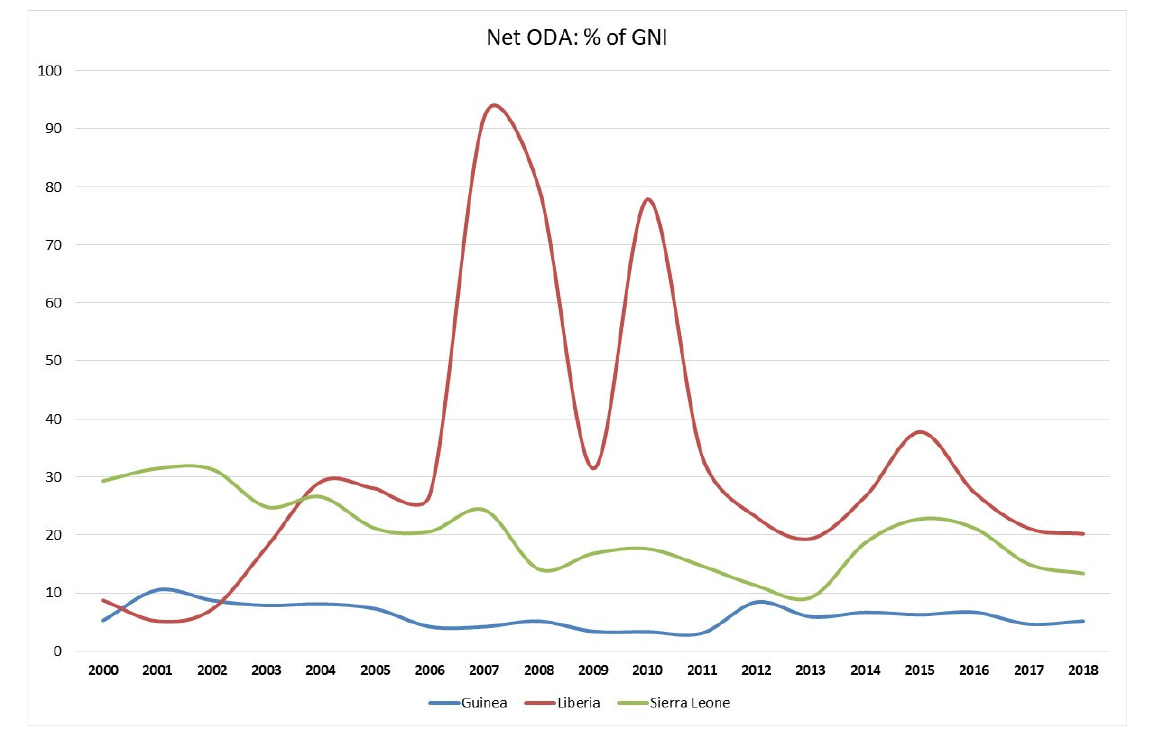
Figure 4. Net ODA flows in relative terms. Source: World Bank: WDI.